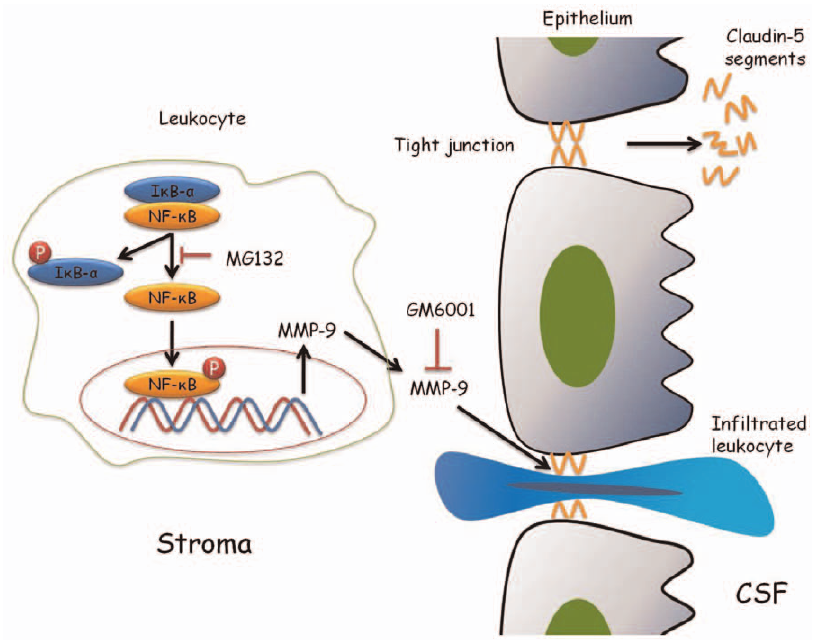
Figure 6. Possible mechanisms of matrix metalloproteinase (MMP)-9 leading to claudin-5 degradation via the NF- k B pathway. The activation of I k B- a and NF- k B could upregulate MMP-9 production in A. cantonensis -induced leukocytes. Blocking I k B- a and NF- k B signaling by MG132 could reduce MMP-9 production. Further, blocking MMP-9 activity by GM6001 could reduce claudin-5 degradation and blood-CSF barrier permeability during angiostrongyliasis meningoencephalitis. Therefore, we suggest that MMP-9 could cause claudin-5 degradation and promote leukocyte infiltration into CSF by the paracellular route during A. cantonensis infection in mouse choroid plexus.